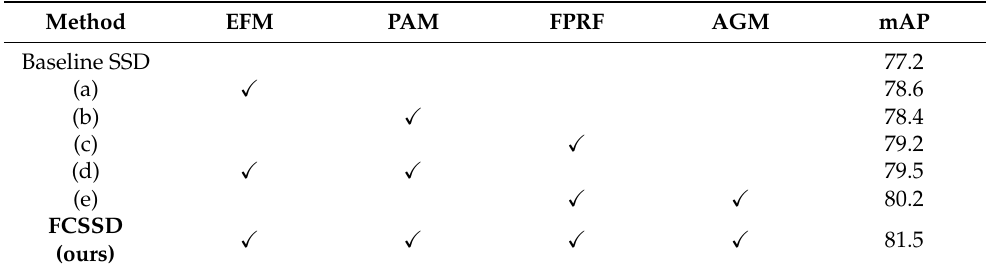
Table 4. Ablation studies of the FCSSD on the PASCAL VOC 2007 test set with an image size of 300 × 300.